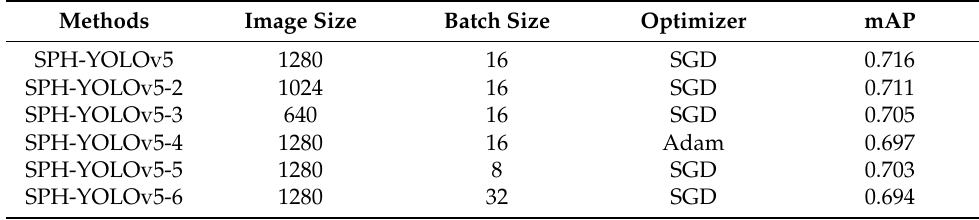
Table 7. The effects of adjusting